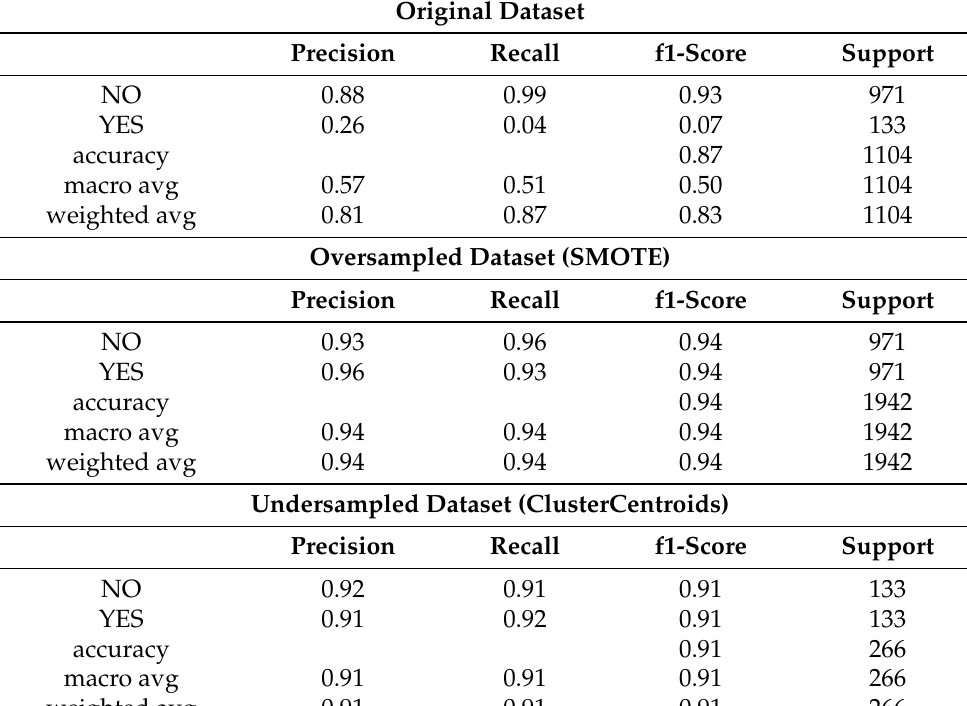
Table 5. Classification report after different sampling of